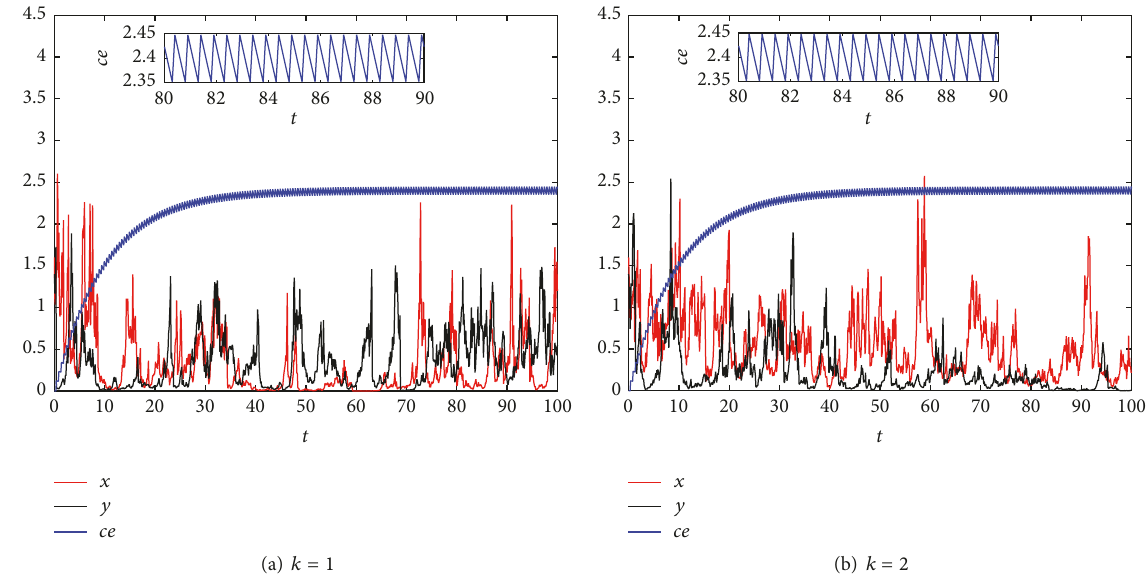
Figure 6: Sample paths of 𝑥(𝑡) , 𝑦(𝑡) with initial value 𝑥(0) = 1.6 and 𝑦(0) = 1.4